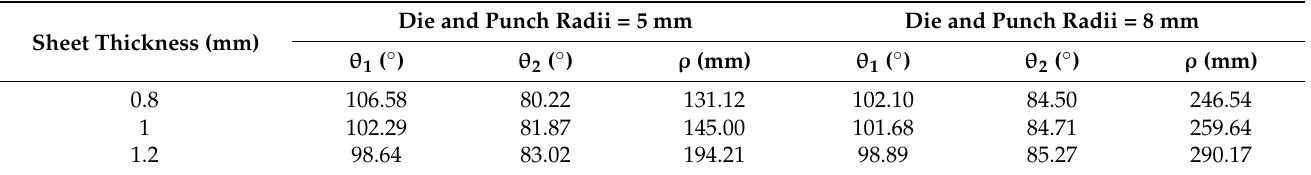
Table 4. Springback values for single SA5182 with die/punch radii of 5 mm and 8 mm. Sheet Thickness